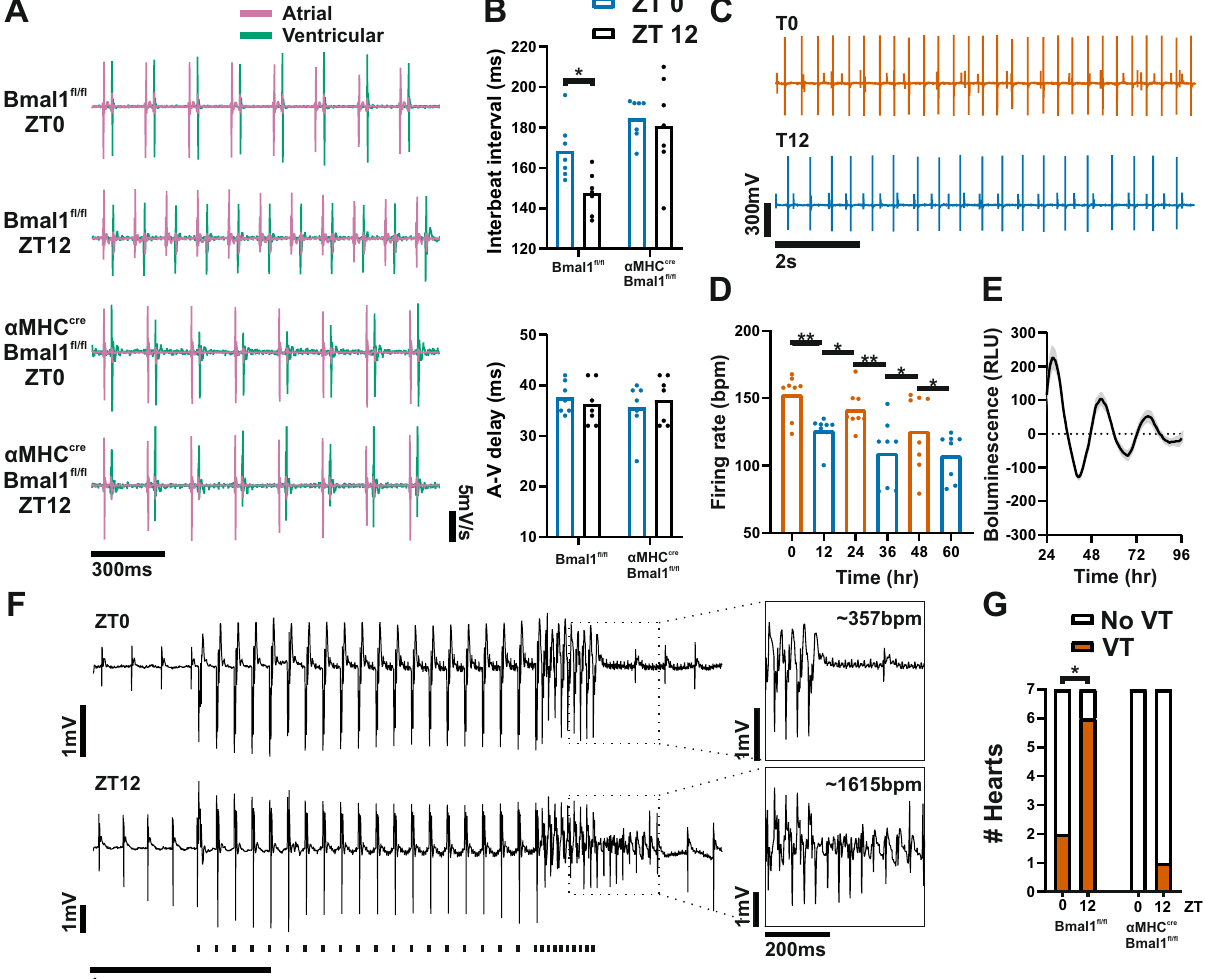
Fig. 5 A local heart clock drives time-of-day-dependent rhythms in cardiomyocyte excitability. A Representative recordings of spontaneous atrial (pink) and ventricular (green) electrograms recorded in ex vivo Langendorff-perfused hearts collected from control ( Bmal1 Fl/Fl ) and α MHC CRE Bmal1 Fl/Fl mice at ZT0 or ZT12. B Interbeat interval showed a time-of-day (ZT0 blue, ZT12 black) difference in control but not α MHC CRE Bmal1 Fl/Fl hearts; A – V conduction delay in isolated hearts did not vary by time of day ( n = 7 hearts/group, two-way RM ANOVA, Sidak ’ s post hoc). C Representative multielectrode array recording of spontaneous action potential fi ring in primary cardiomyocytes. D , E Spontaneous fi ring rate in isolated cardiomyocytes showed robust circadian variation in constant culture conditions ( D , n = 8, one-way RM ANOVA, Holm – Sidak post hoc), which followed rhythms of mPER2::LUC bioluminescence recorded in parallel cultures (RLU: relative light units, E ). F Representative ventricular traces and pacing protocol (stimulation train shown below recording). Inset showing recovery to normal sinus rhythm (top) and induced ventricular tachycardia (VT; bottom). G Control hearts ( n = 7/ timepoint) showed a signi fi cant time-of-day susceptibility to VT (ZT0: 2 of 7 hearts tested, ZT12: 6 of 7; Chi-square), whereas only 1 of 14 α MHC CRE Bmal1 Fl/Fl hearts ( n = 7/timepoint) were susceptible. All data presented as mean ± SEM. * P < 0.05, ** P < 0.01. Source data and statistical details are provided as a Source Data cardiomyocyte clock in fl uences over SA and AV nodal activity.